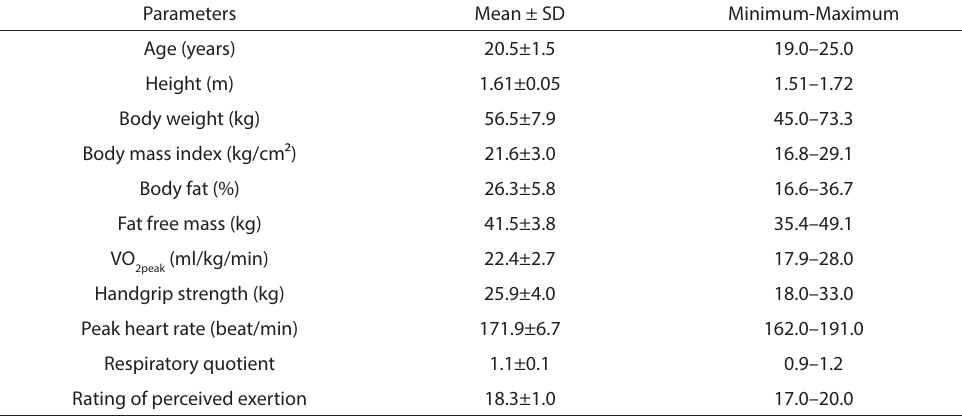
Table 1. Mean (± SD), Minimum and Maximum Values of Demographic Data and Assessed Parameters